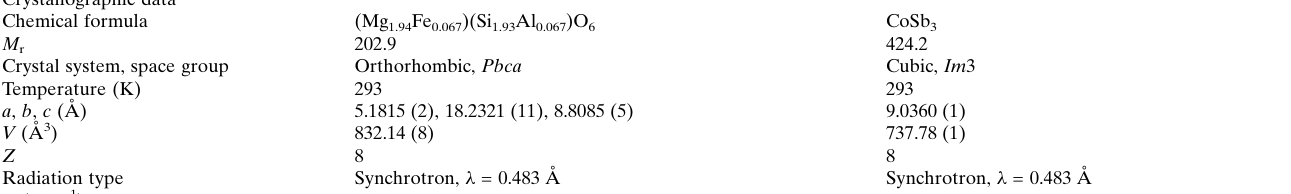
Table 2 Details of the crystal structure refinements of the test samples orthoenstatite (Mg 1.93 ,Fe 0.06 )(Si 1.93 ,Al 0.06 )O 6 and CoSb 3 . Atomic displacement parameters of the cations were refined with anisotropic approximation. For additional information on the crystal structures and refinement parameters we refer the reader to the CIFs in the supporting information. Crystallographic data Chemical